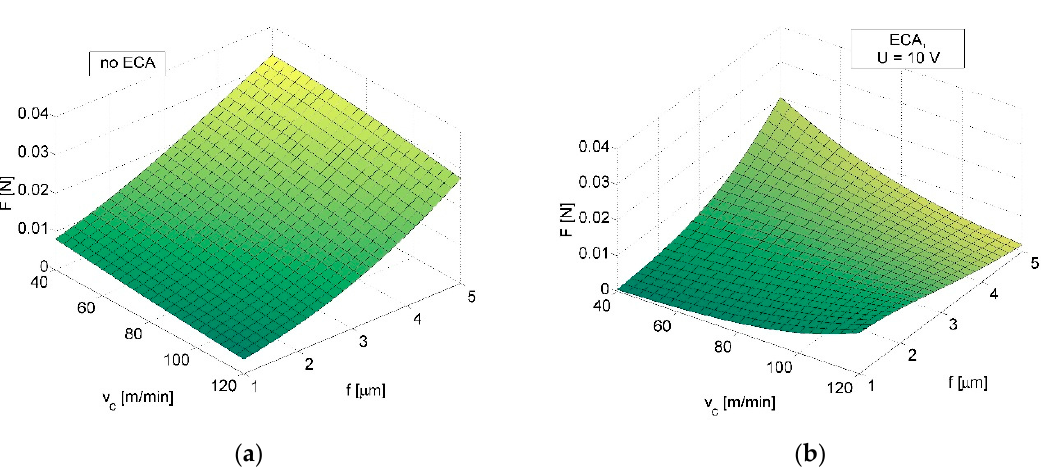
Figure 3 . Relationship between sensor load and cutting speed V c and feed rate f for a p = 3 µm; machining without ECA ( a ) and machining with ECA in variant A ( b ).